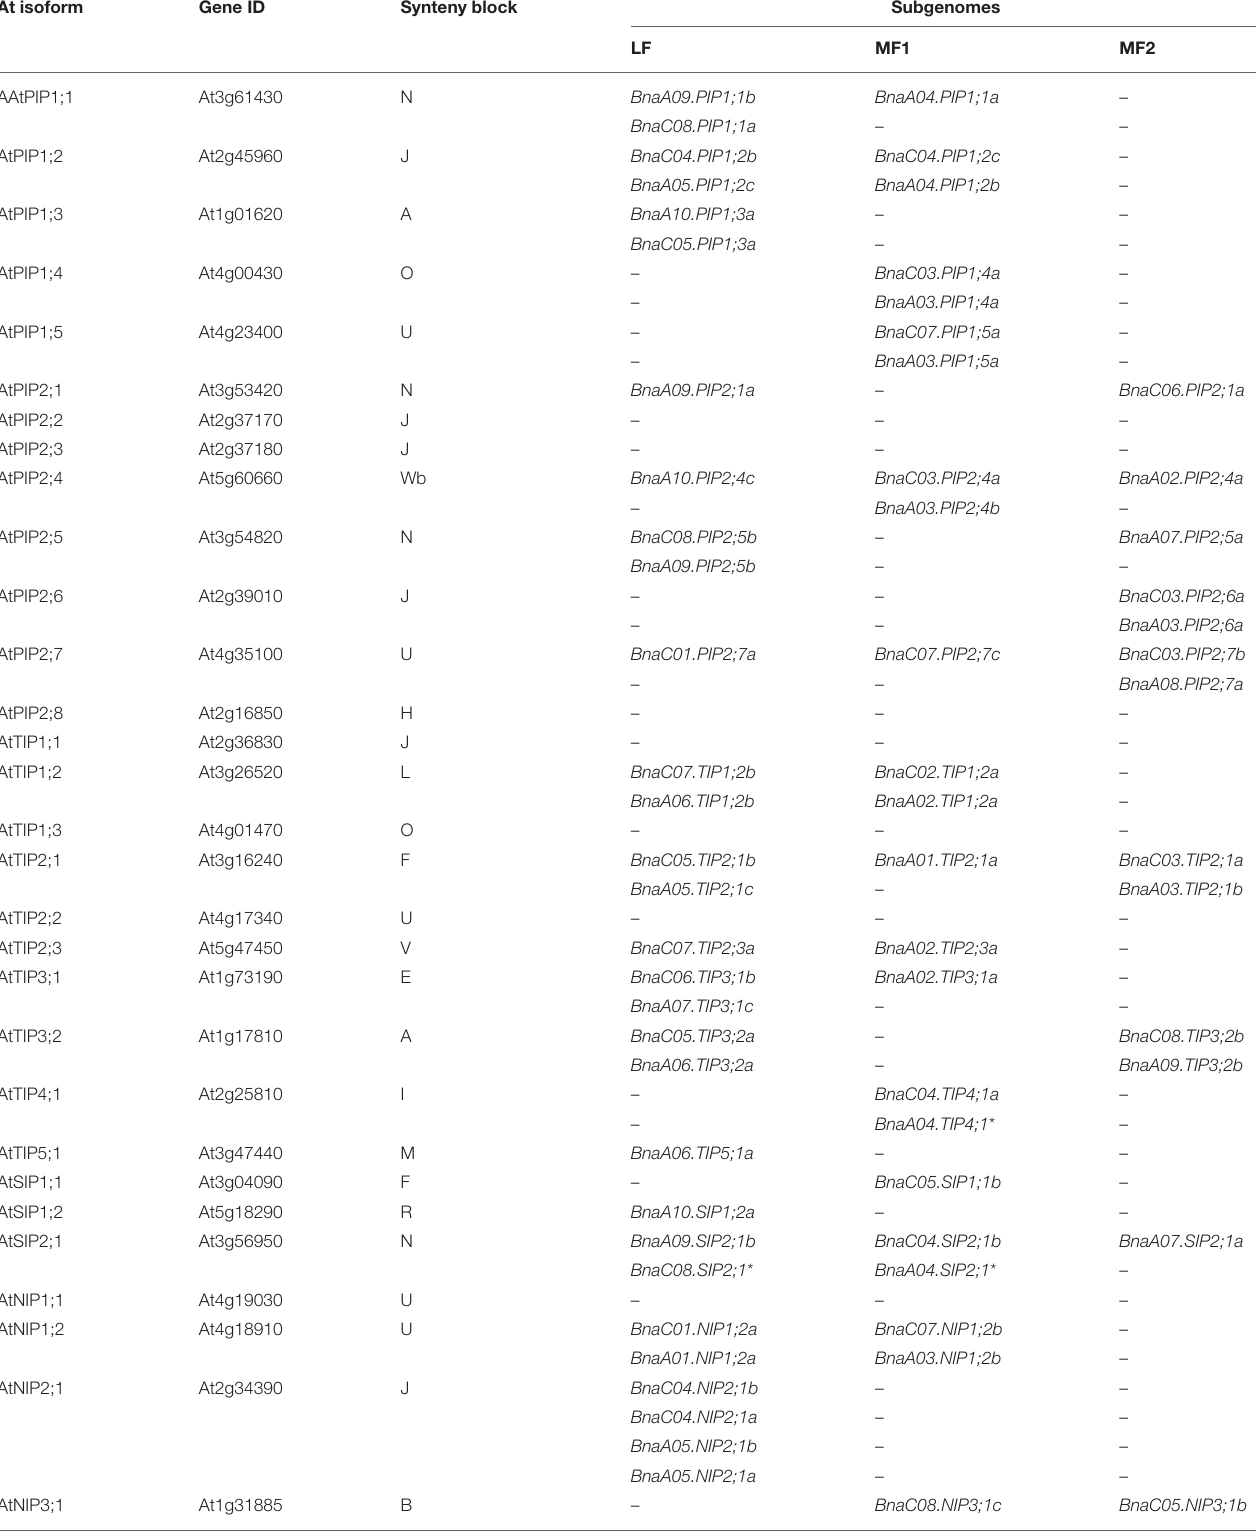
TABLE 2 | Synteny block and distribution of aquaporin genes in the three sub-genomes of Brassica napus . At